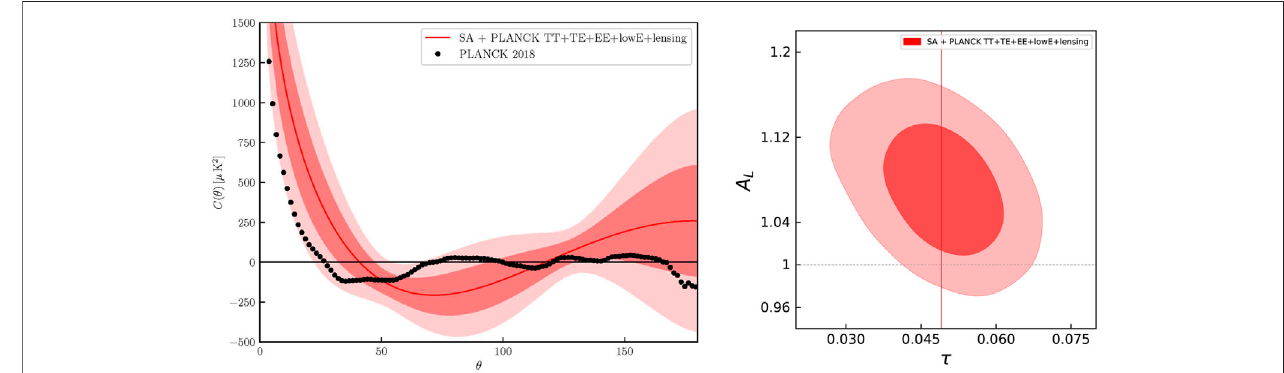
FIGURE 2 | Left Panel: Large scale power anomaly as measured by C ( θ ) . The (red) continuous curve is the theoretical prediction from the SA with 68 and 95% con fi dencelevel contours arisingfromcosmicvariance, whilethe(black)dots represent the2018PLANCK team measurements. The SA prediction for S 1 / 2 ismorethan 35 times the observed value. Right Panel: Lensing amplitude A L vs. optical depth τ A L (cid:1) 1 lies outside the 1 σ contour, signaling the tension between theory and